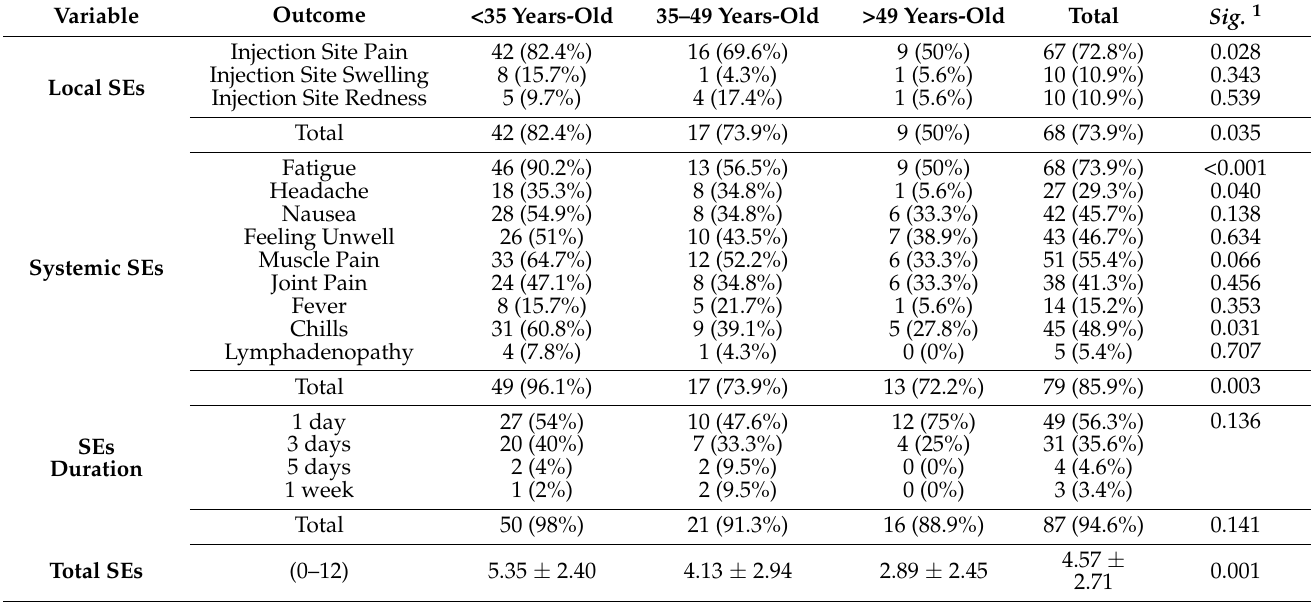
Table 3. Local and systemic side effects of AstraZeneca COVID-19 vaccine among European healthcare workers, February– March